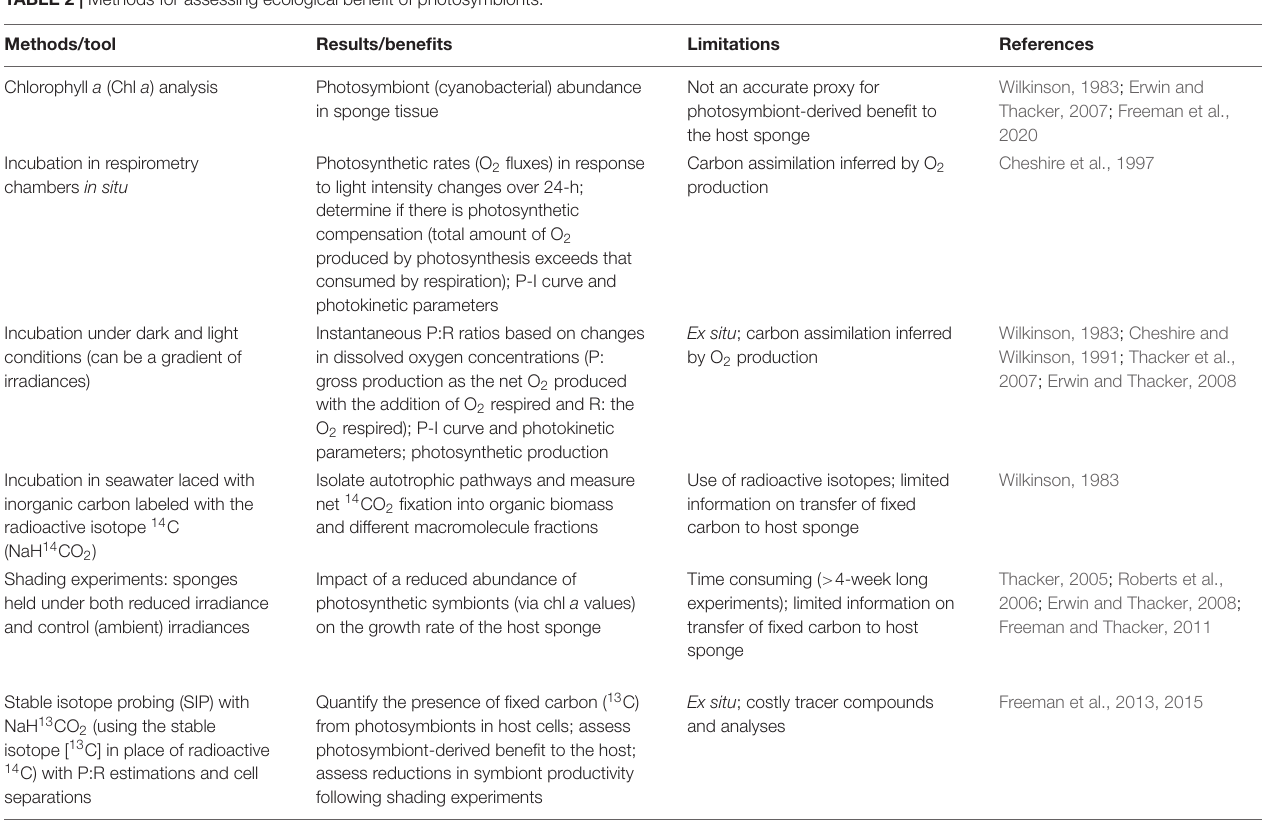
TABLE 2 | Methods for assessing ecological benefit of